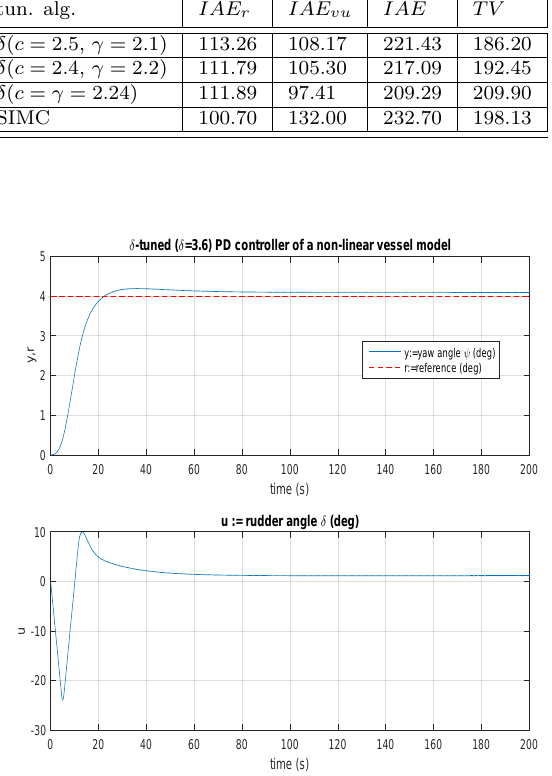
Figure 17: Shows PD control of the non-linear vessel model in Eq. (49). The PD controller is tuned using δ -tuning Alg. 2.1 with pre- scribed robustness δ = 3 . 6 and tune alter- native